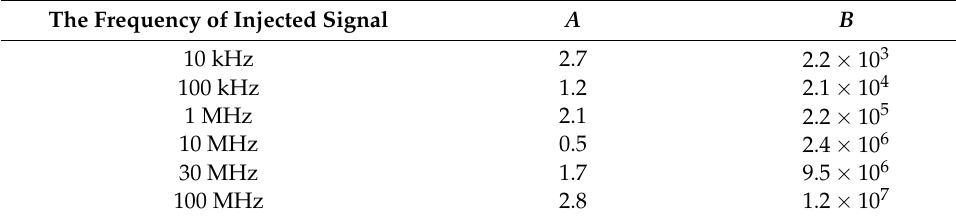
Table 2. The parameters of A and B.